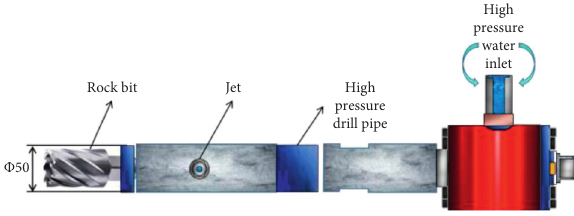
Figure 9: High-pressure water jet.